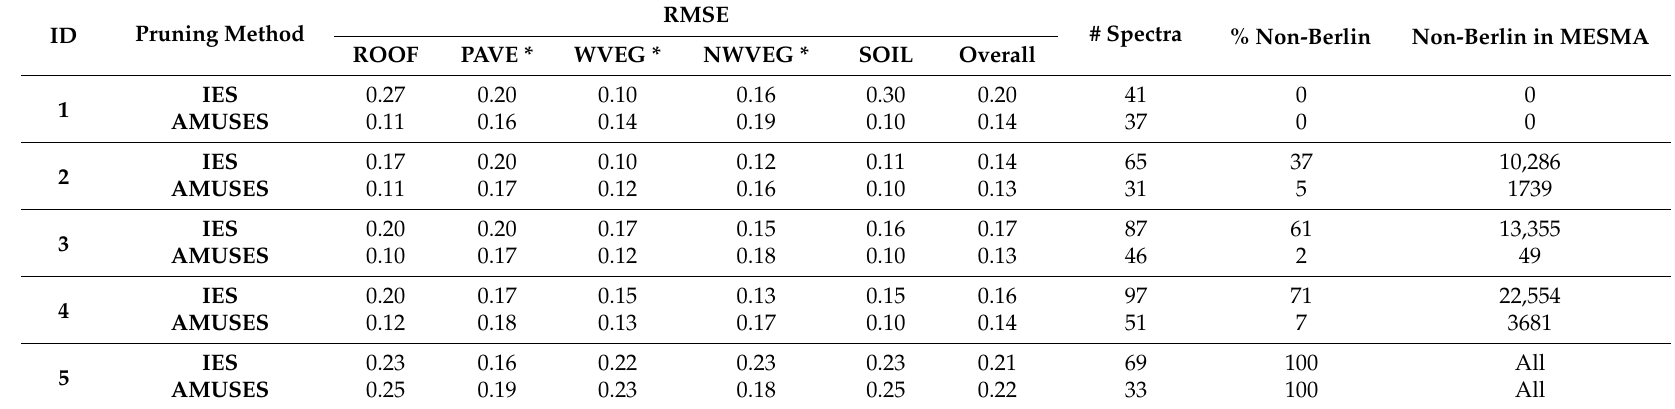
Table 4. Comparison of validation results between the IES and AMUSES pruning algorithms for our five experiments on the Berlin dataset (identified by ID, see Table 3). Overall and class-wise root mean square errors (RMSE) originate from comparing reference and estimated land cover fractions at block level.